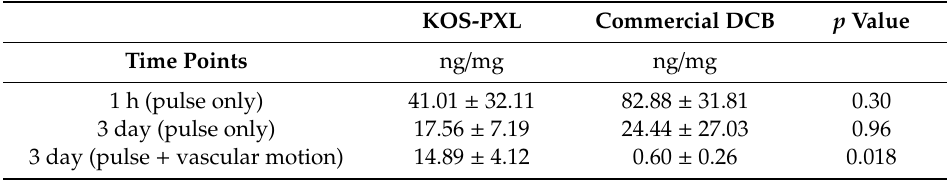
Figure 2. Paclitaxel levels of the drug-coated balloon (DCB) and the keratose–paclitaxel (KOS-PXL)-coated balloon arterial segments undergoing pulsatile flow conditions versus pulsatile flow conditions with vascular motion. Table 1. Ex vivo arterial drug concentration measurements of treated arteries.